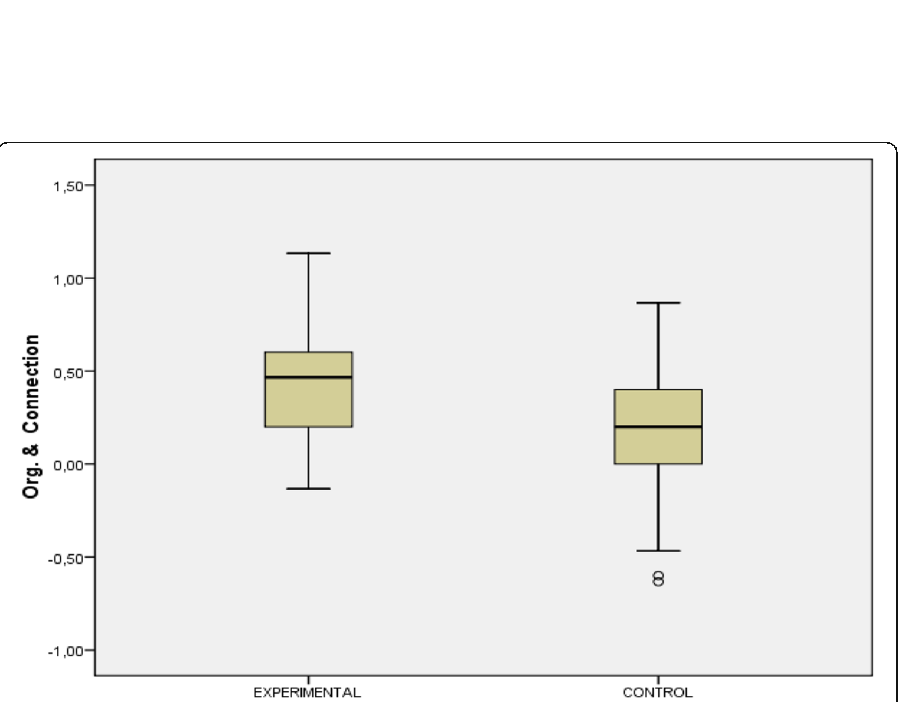
Fig. 5 Box-and-whisker plot of pre-treatment progress in organising and linking ideas in both